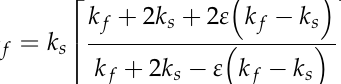
Figure 5. Comparison of effective thermal conductivity between numerical results and analytical data.